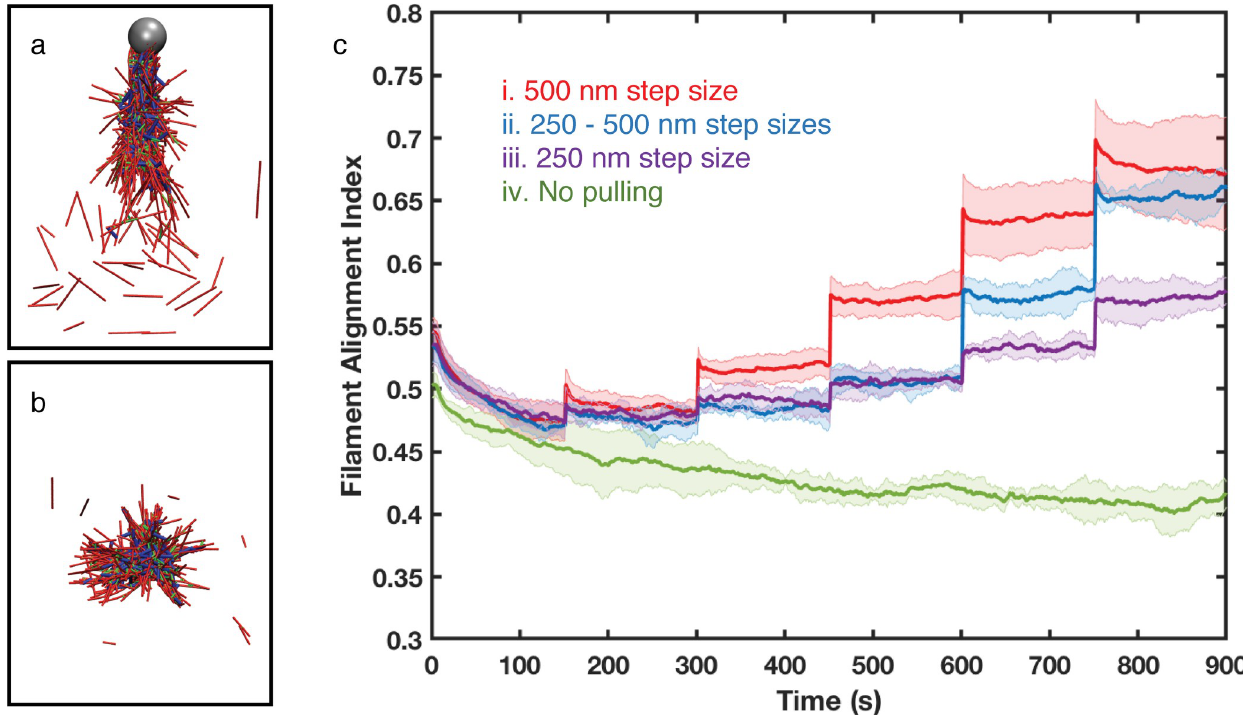
Fig 3. (a-b) Representative snapshots of (a) bundle-like actin networks under Case i pulling condition at time t = 900 s, and (b) cluster-like actin networks without external force at time t = 900 s. Actin filaments, myosin motors, and crosslinkers are shown in red, blue, and green cylinders, respectively. The gray sphere in (a) represents the AFM probe. (c) Filament alignment index along the Z-axis for 500 nm step size (red, Case i), mixed step sizes (250 nm for the first three pulling events and 500 nm for the last two, blue), 250 nm step size (purple, Case ii) and no AFM-probe pulling (green, Case iii). α -actinin linker: actin is 0.1 and myosin:actin is 0.005 in all simulations. Error bars represent the standard deviation from the mean in 5–10 simulation